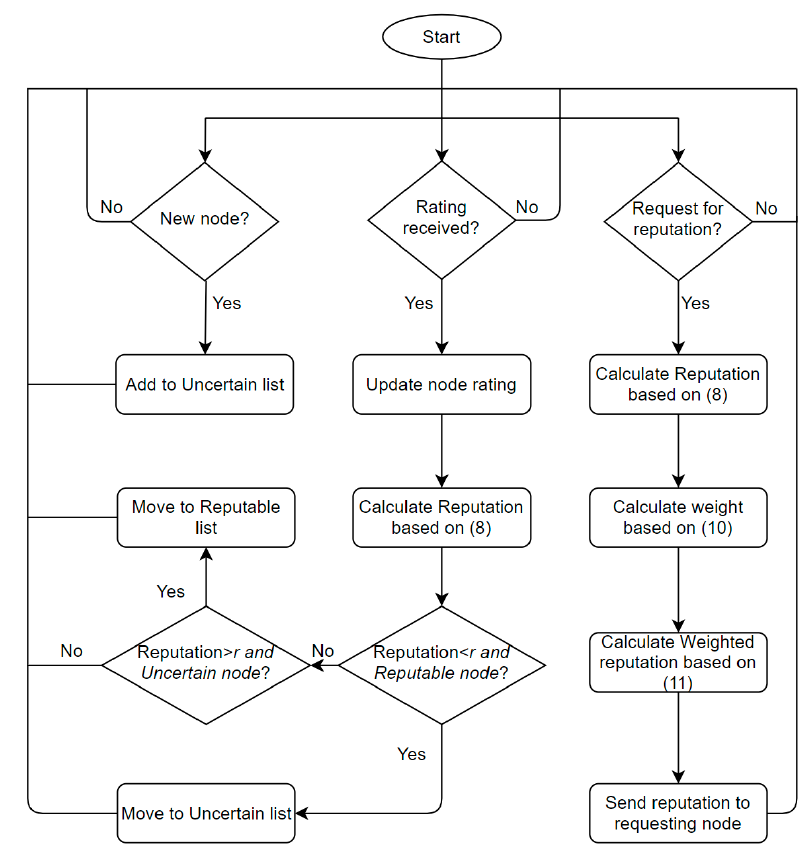
Figure 5. WhatsTrust system algorithm.